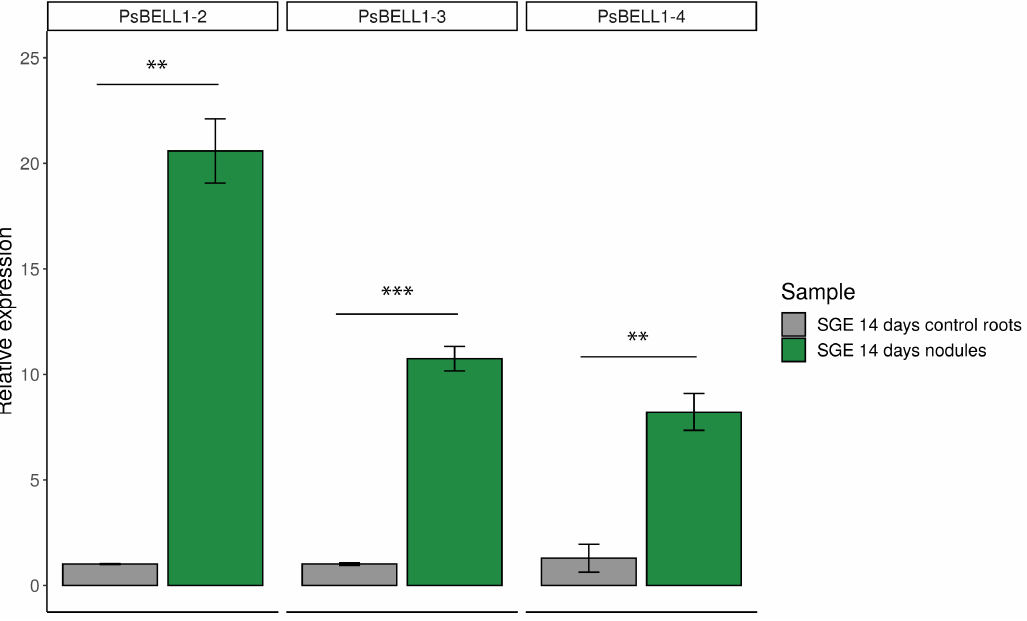
Figure 3. RT-qPCR analysis of PsBELL1-2 (Psat4g090560) , PsBELL1-3 (Psat0s189g0080) and PsBELL1- 4 (Psat7g031320) expression in pea nodules (SGE line). mRNA levels were normalized against